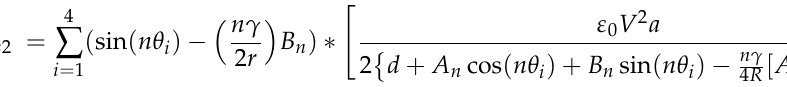
Figure 3. A Schematic of ring and electrodes